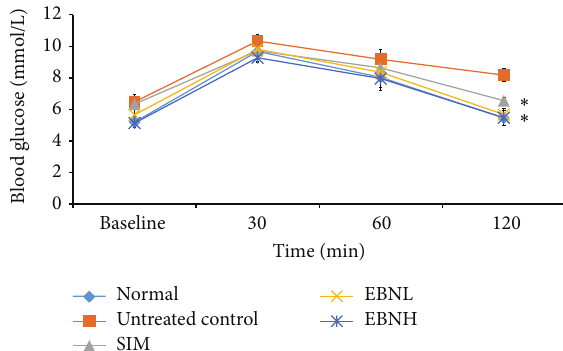
Figure3:Effectsofediblebird’snest(EBN)onoralglucosetolerance test in fed high fat diet- (HFD-) fed rats. Groupings are similar to Figure 2. ∗ indicates significant difference ( 𝑃 < 0.05 ) in comparison with untreated